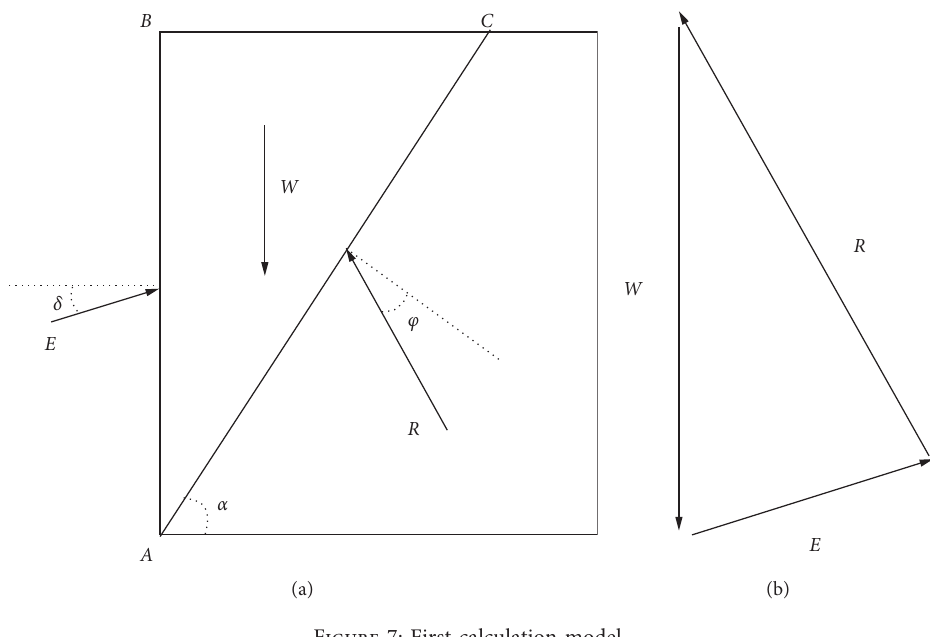
Figure 7: First calculation model.